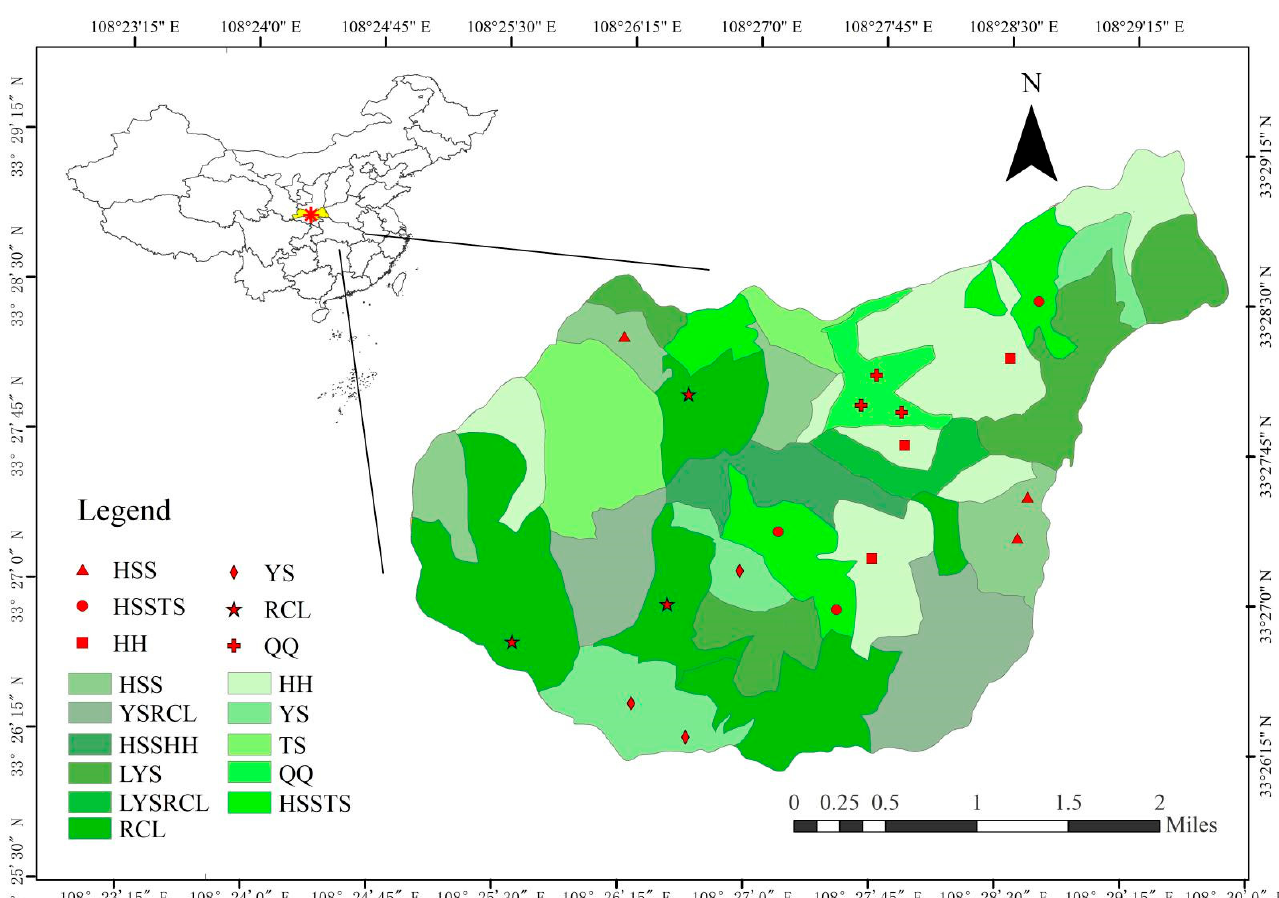
Figure 1. Plot distribution map. Different colors represent different forest communities, and the red-marked points are the locations of the sample plots. HSS indicates Pinus armandii forest, YS indicates Pinus tabulaeformis forest, HSSTS indicates mixed P. armandii and Tsuga chinensis forest, RCL indicates Quercus aliena var. acuteserrata forest, HH indicates Betula albosinensis Burkill forest, QQ indicates Picea wilsonii forest, YSRCL indicates mixed P. tabulaeformis and Q. aliena var. acuteserrata forest, HSSHH indicates mixed P. armandii and B. albosinensis Burkill forest, TS indicates T. chinensis forest, LYS indicates Larix principis-rupprechtii forest, LYSRCL indicates mixed L. principis-rupprechtii and Q. aliena var. acuteserrata forest.